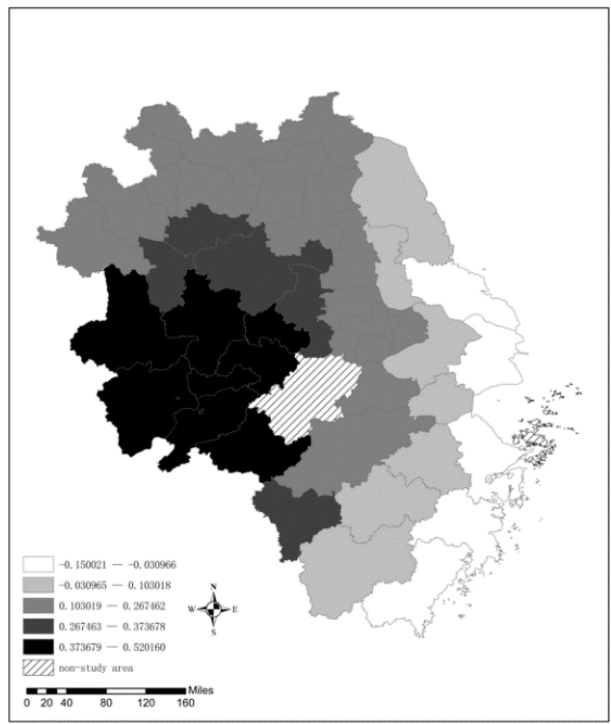
Figure 10. The spatial distribution of the regression coefficient for City .